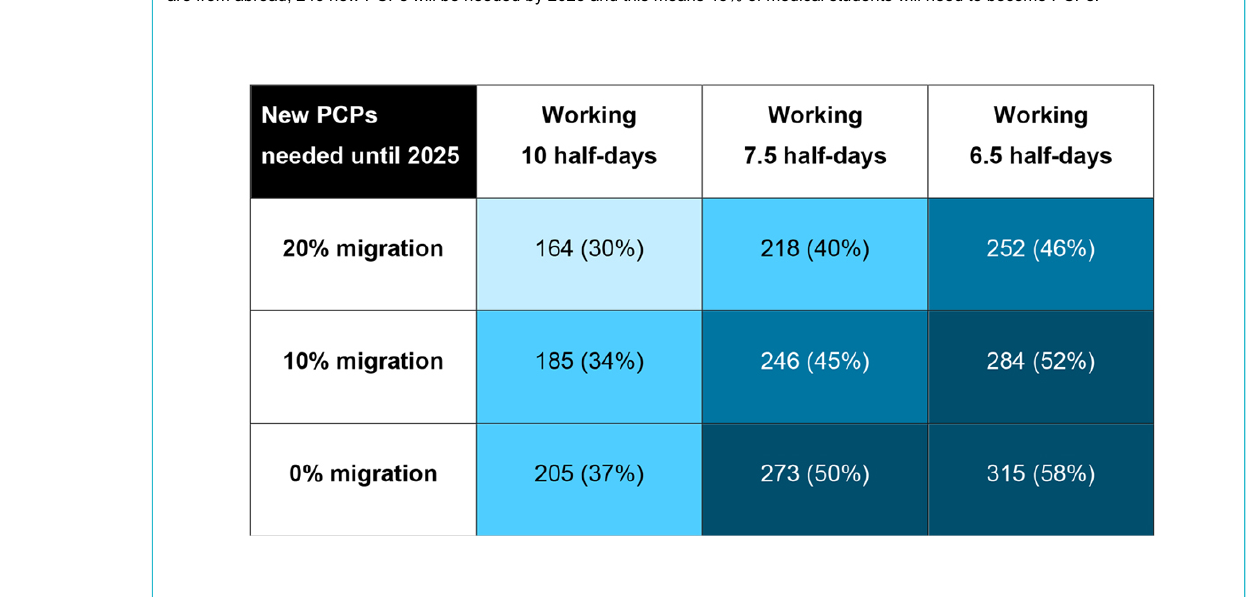
Figure 2: Need for new primary care physicians (PCPs) by 2025 to offset the drop in density between 2020 and 2025 in the Canton of Bern. Percentages in brackets are the estimated proportion of medical students leaving university and working in the Canton of Bern that will need to become PCPs to achieve the needed PCPs. For example, if new PCPs all work 7.5 half-days on average and only 10% of PCPs are from abroad, 246 new PCPs will be needed by 2025 and this means 45% of medical students will need to become